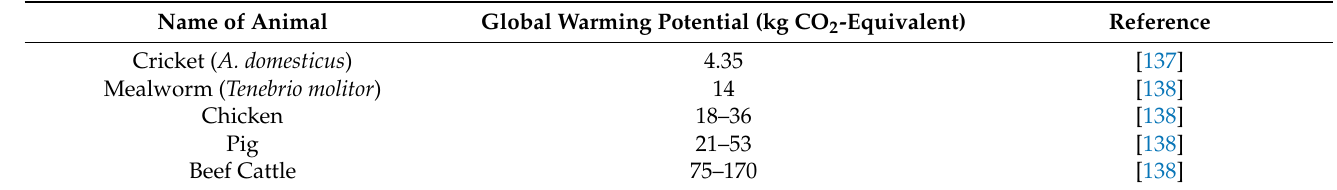
Table 6. The comparison of CO 2 emission per kg edible protein between insect and other conven- tional